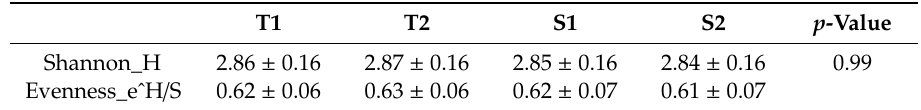
Table 1. Diversity and evenness estimation of the functional categories of soil samples at SEED Subsystem level 1.